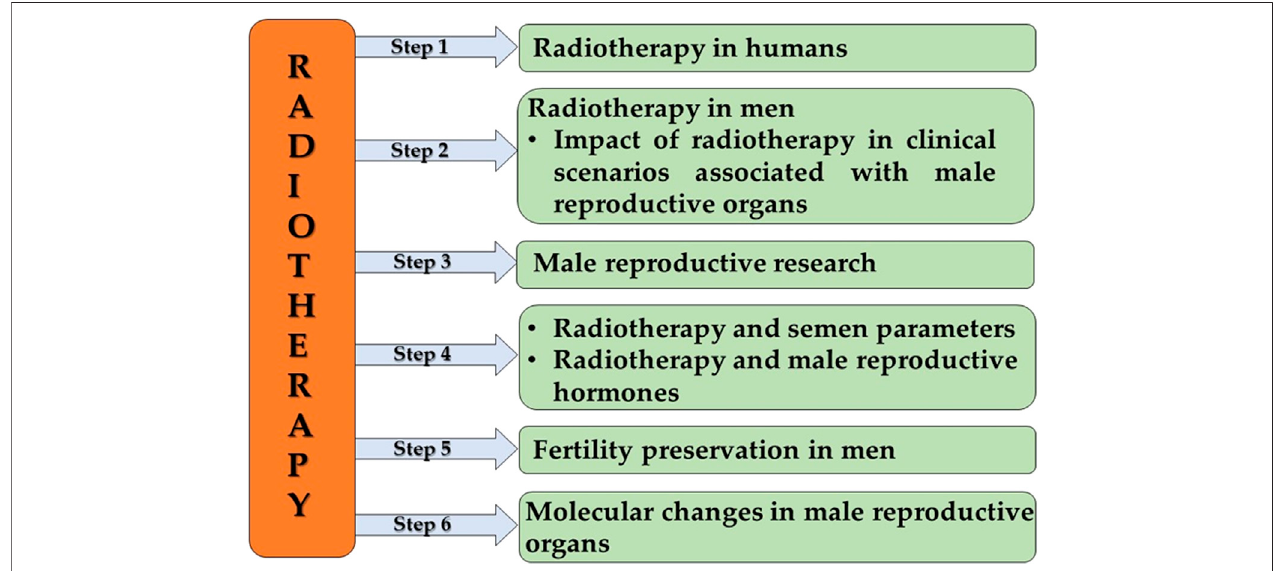
FIGURE 1 | The framework of scientometric analysis. Step 1 analyzed the publication trend in radiotherapy in humans, followed by step 2 which included the analysisofpublicationtrendinradiotherapyinmen,focusingontheimpactofradiotherapyinclinicalscenariosassociatedwithmalereproductiveorgans.Step3analysis was focused on publication trend in radiotherapy and male reproductive research. Step 4 analyzed two aspects, publication trends associated with the impact of radiotherapy on semen parameters and male reproductive hormones. Steps 5 and 6 analyzed the publication trends in radiotherapy associated with fertility preservation in men and molecular changes in male reproductive organs, respectively.